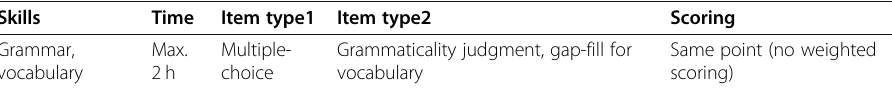
Table 2 Key features of the test instrument Skills Time Item type1 Item type2